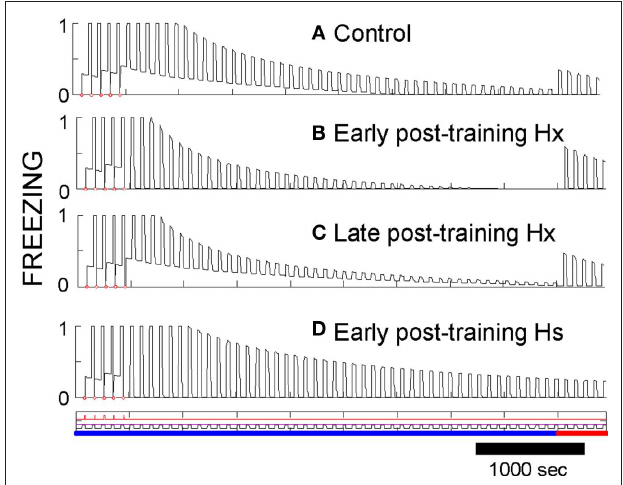
FigurE 9 | Effects of post-training hippocampal ablation or suppression. (A) AAB conditioning, extinction, and renewal shown as a control for other procedures. (B) Hippocampus was ablated right after conditioning. Context fear is lost, but responses to the CS remain and extinguish fairly normally. A switch to context B produces clear renewal. (C) If consolidation was allowed to occur and hippocampus then ablated prior to extinction, context fear is not lost. (D) If extinction is carried out soon after conditioning with the activity of the intact hippocampus-suppressed (no ablation), extinction occurs